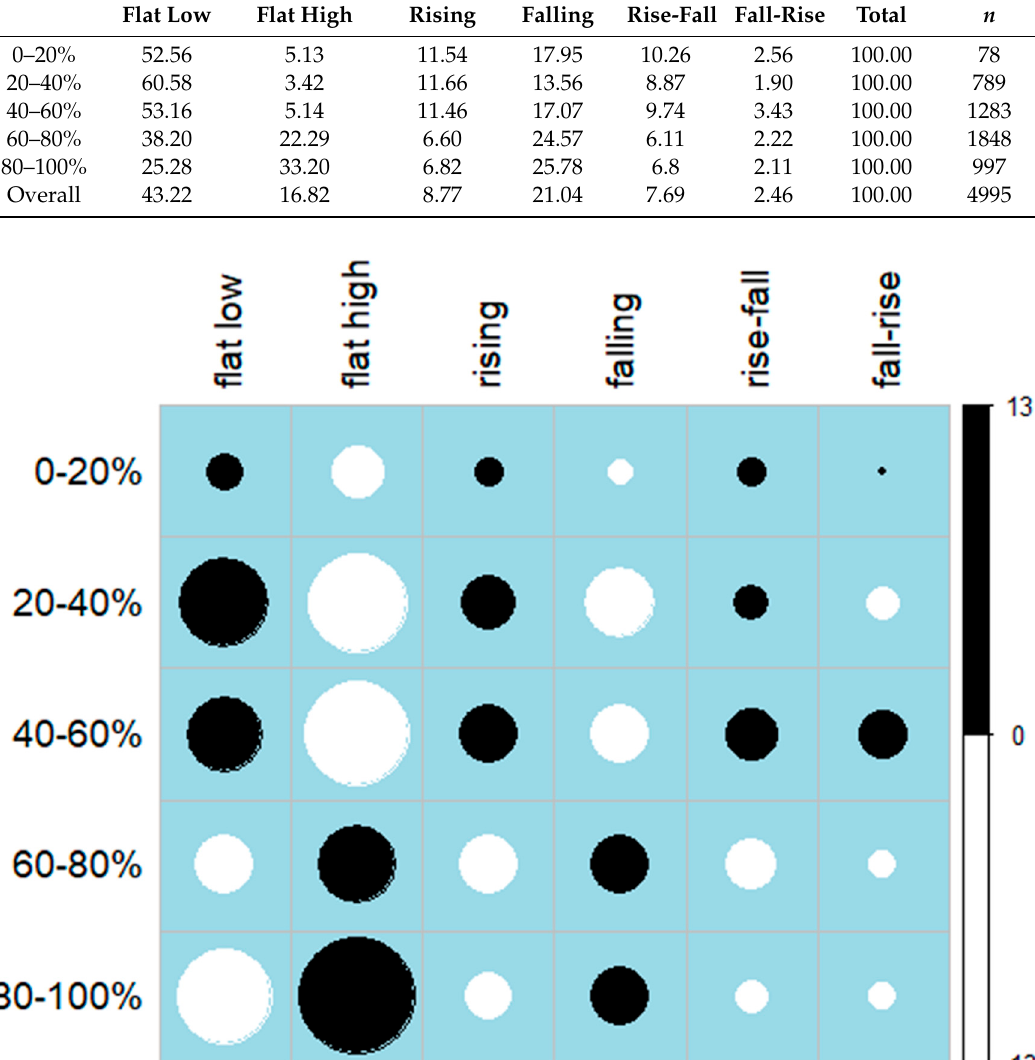
Table 9. Multinomial logistic regression model for profile.